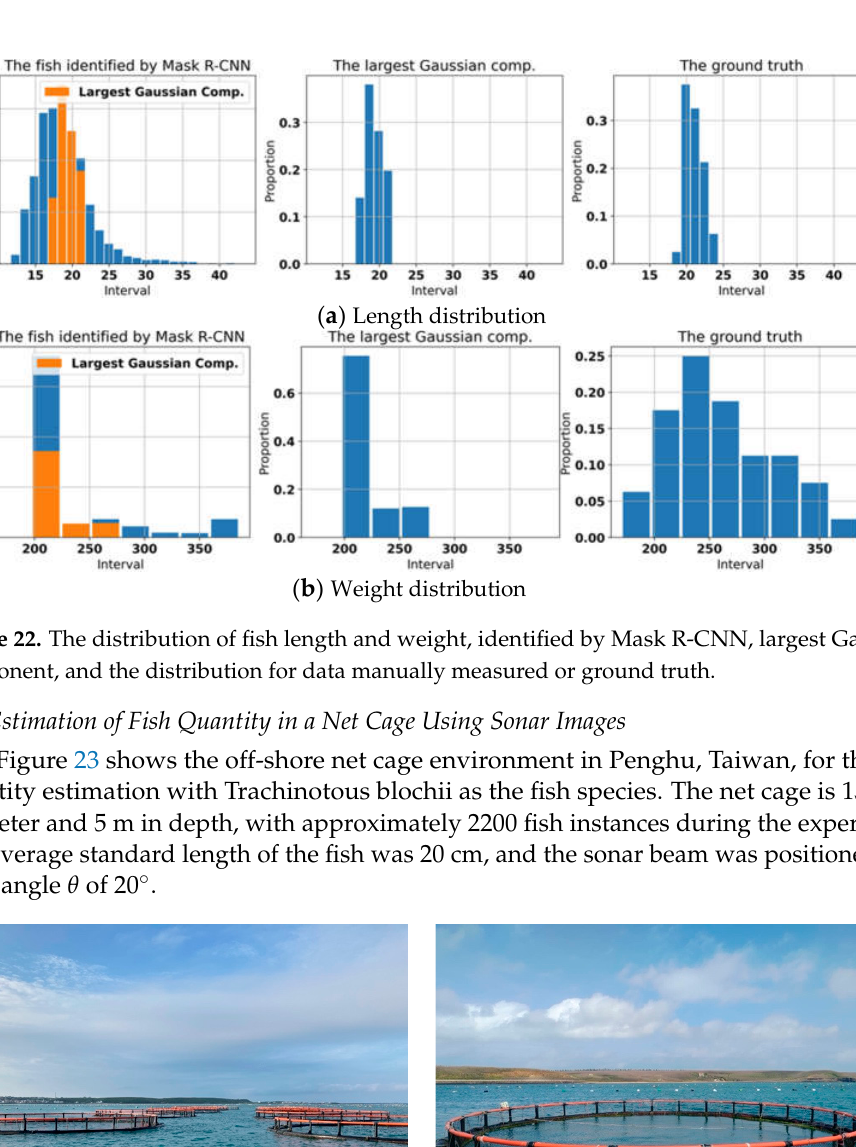
Figure 23. Off-shore cages in Penghu, Taiwan, where ( a ) shows the landscape of the off-shore net cages; and ( b ) is the environment of the net cage used for the experiment. The dataset used to train the CNN in detecting fish-gathering frames consisted of 58 fish-gathering images and 116 fish-dispersing images. The CNN was evaluated using 10- fold cross-validation and obtained an accuracy of 0.98. Table 3 shows the confusion matrix results. The intersection over union (IoU) was adopted to represent the performance index for the semantic segmentation network to segment the fish region. This network was eval- uated using 10-fold cross-validation, and the average IoU was 0.77 ± 0.66. Table 3. The confusion matrix for the CNNs’ detection of fish gathering frame.